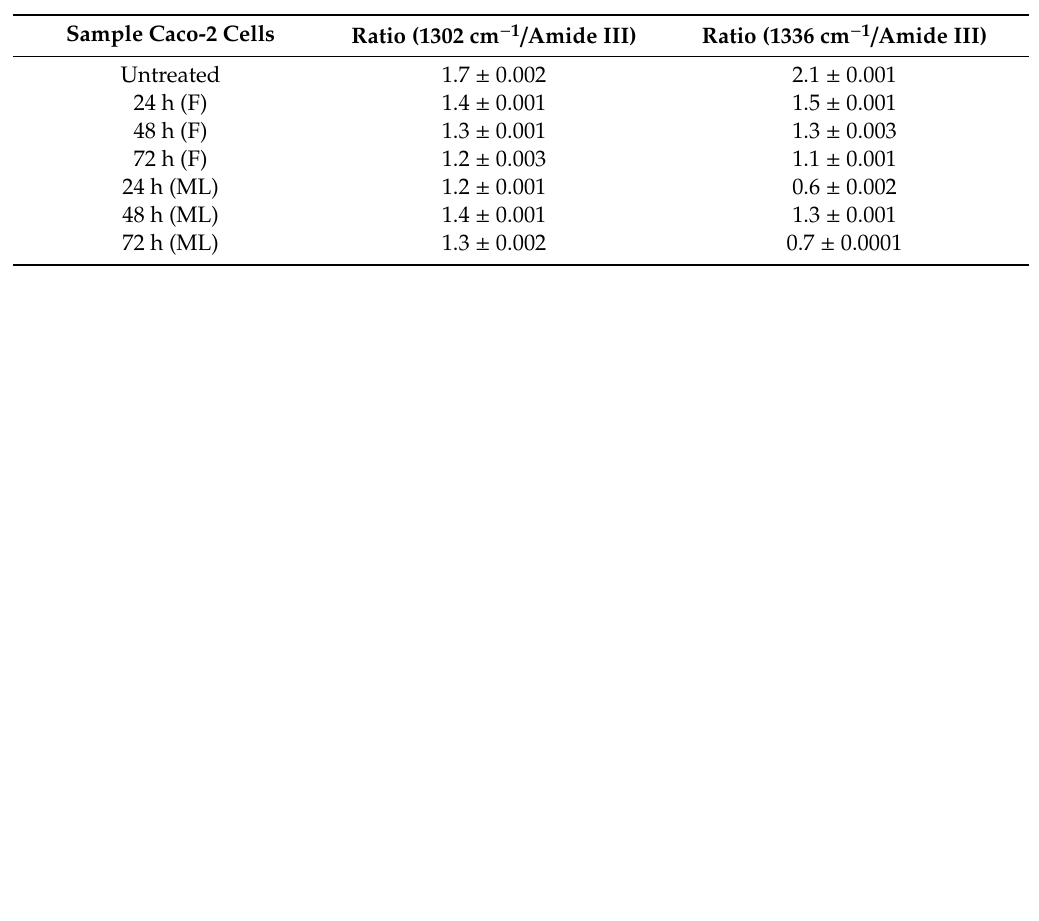
Table 3. Ratio of the peak area of the 1302 cm − 1 band assigned to the lipid deformation mode, or at 1336 cm − 1 assigned to DNA bases guanine and adenine and the area of amide III bands related to protein vibration. Caco-2 cells were treated with 24, 48 and 72 h UV-radiated fish oil (F) or methyl linoleate